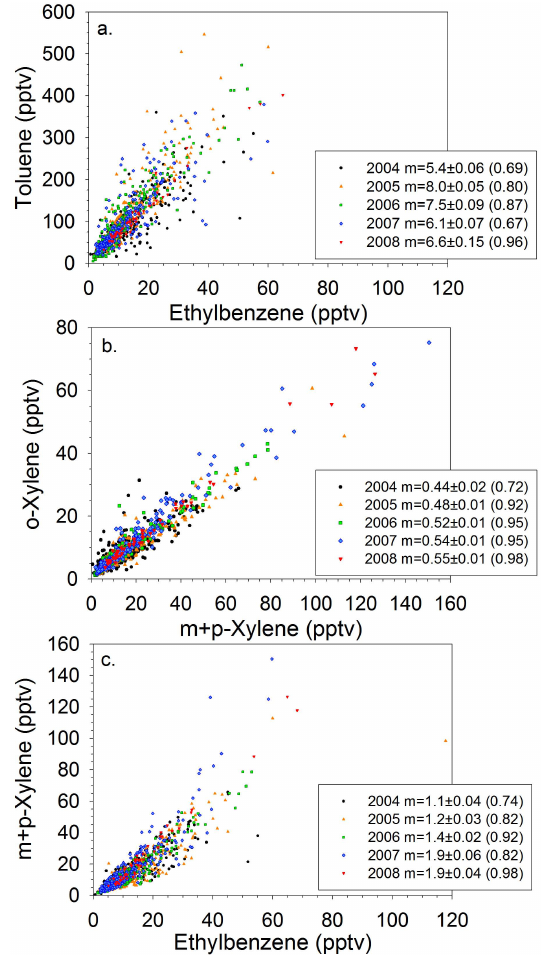
Fig. 8. Correlations ( m =slope ± standard error ( r 2 )) between (a) toluene and ethylbenzene, (b) o-xylene and m+p-xylene, and (c) m+p-xylene and ethylbenzene for each